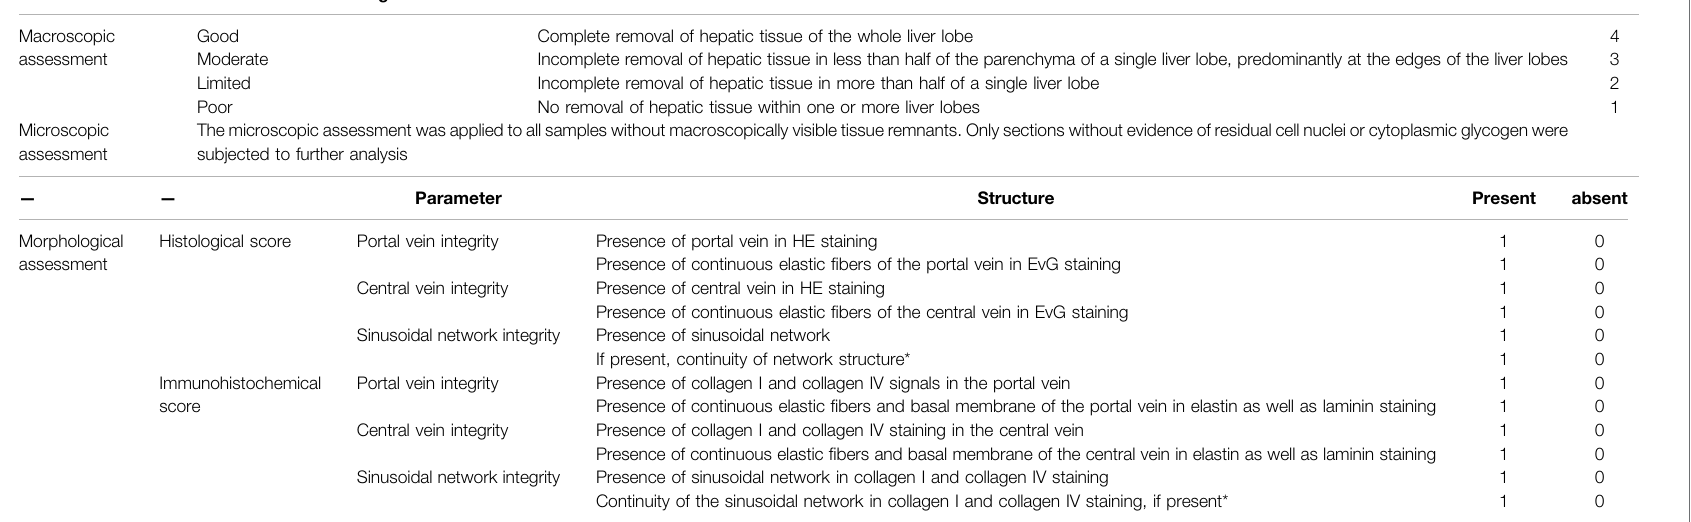
TABLE 2 | The sequential morphological work fl ow to identify liver scaffold-sections with well-preserved microarchitecture. — Grading Structure